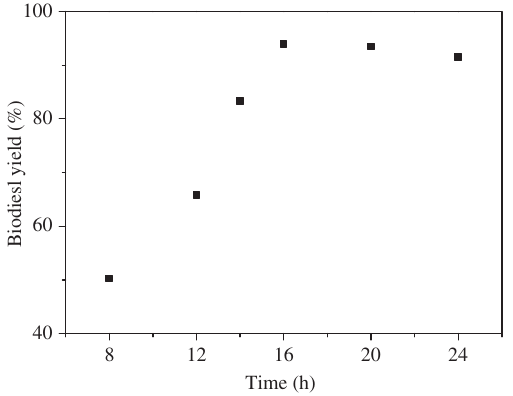
Figure 4 Effect of reaction time on biodiesel yield [reaction condi- tions: w (molar ratio of water to surfactant) 3.5, lipase 4.4%, molar 0